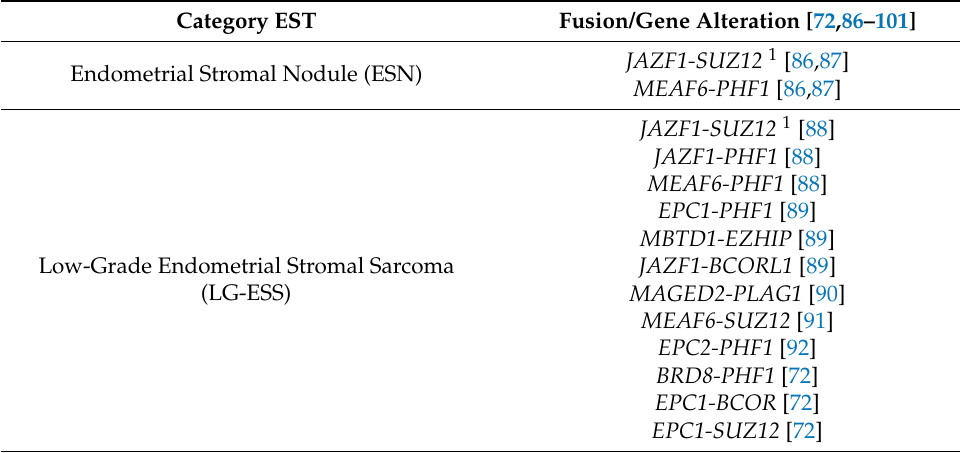
Table 2. Molecular features of endometrial stromal tumors